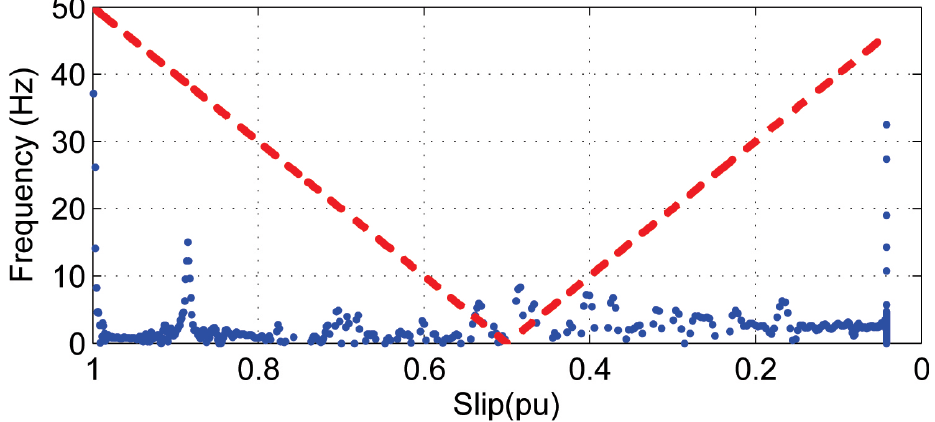
Figure 12. Experimental IF of the LSHst extracted from the current of a healthy machine. Dashed, red line: theoretical evolution of the fault harmonic. Blue dots: evolution of the fault harmonic of the experimental